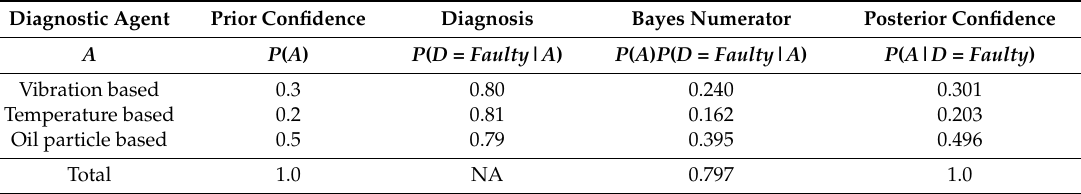
Table 3. Posterior confidence levels of diagnostic agents for the main bearing.